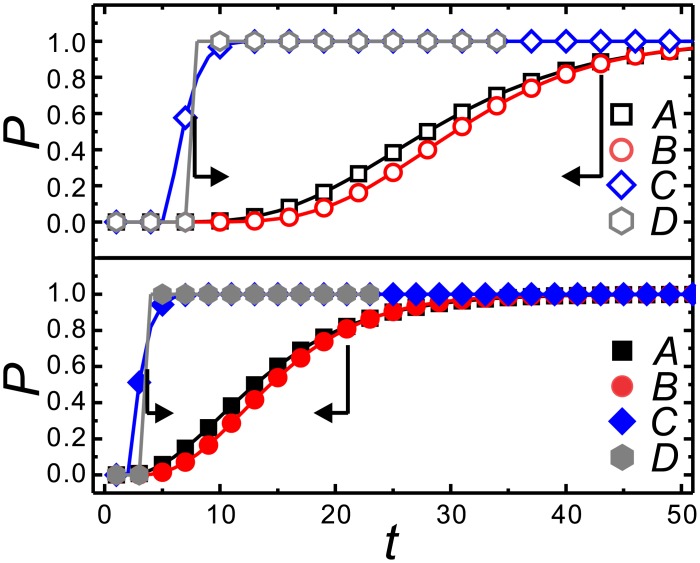
The CDF curves for decisions between A(4000, 0.2) and B(3000, 0.25), and between C(4000, 0.8) and D(3000, 1) with G of 24000 (upper panel) and 12000 (lower panel).A possible explanation resulted from our model − the majority of subjects that took A and D might imply that they wish to achieve a goal of 12000 within 5 < t < 20 or to achieve a goal of 24000 within 10 < t < 42. If these subjects wish to achieve the goal by t = 30, it could be estimated that the goal in mind is about 24000.